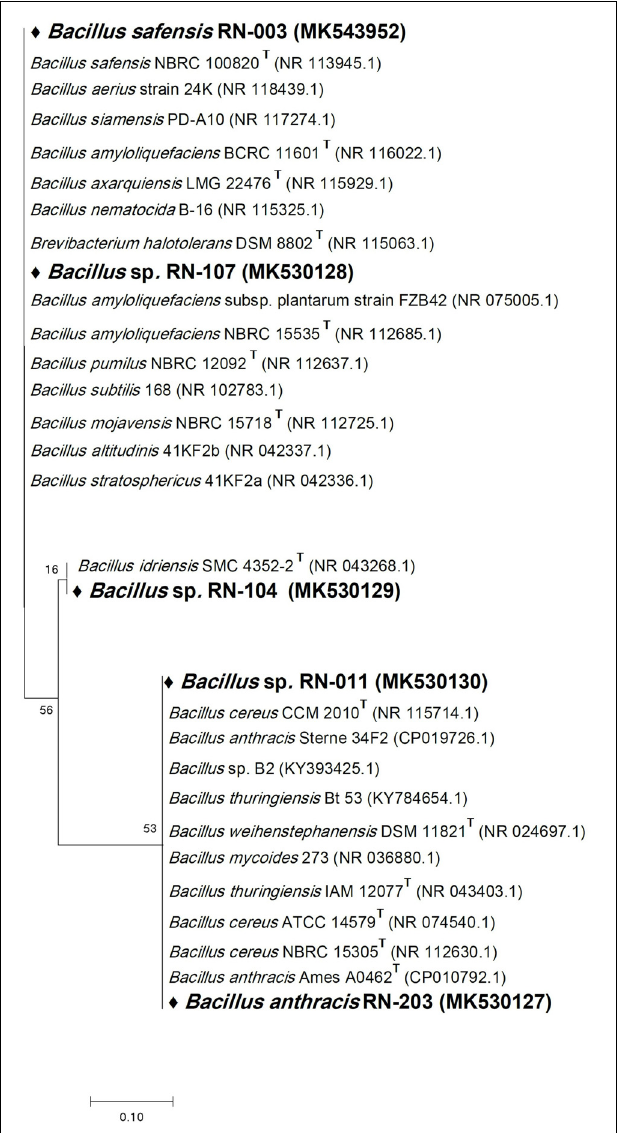
FIGURE 1 | Phylogenetic tree of the River Nile derived isolates based on partial 16S rRNA gene sequences. The phylogenetic tree was inferred using the Neighbor-Joining method (Saitou and Nei, 1987). The distances were computed using the Kimura 2-parameter method (Kimura, 1980) and are in the units of the number of base substitutions per site. Numbers at nodes indicate percentages of 1000 bootstrap re-samplings. All positions containing gaps and missing data were eliminated. Evolutionary analyses were conducted in MEGA7 (Kumar et al.,